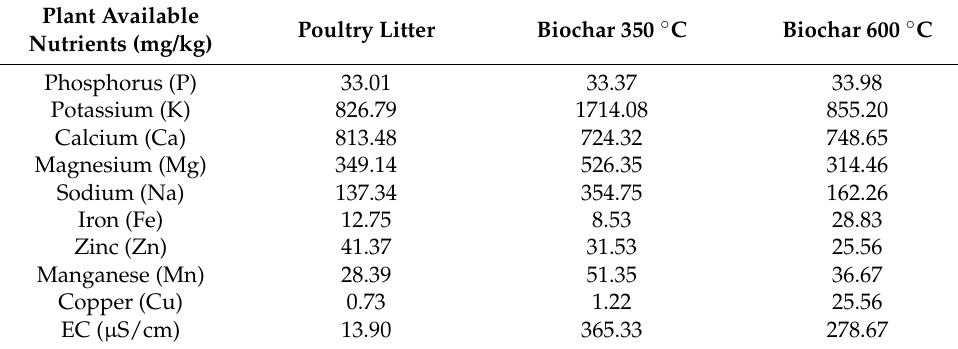
Table 2. Plant available nutrients concentrations in poultry litter and its